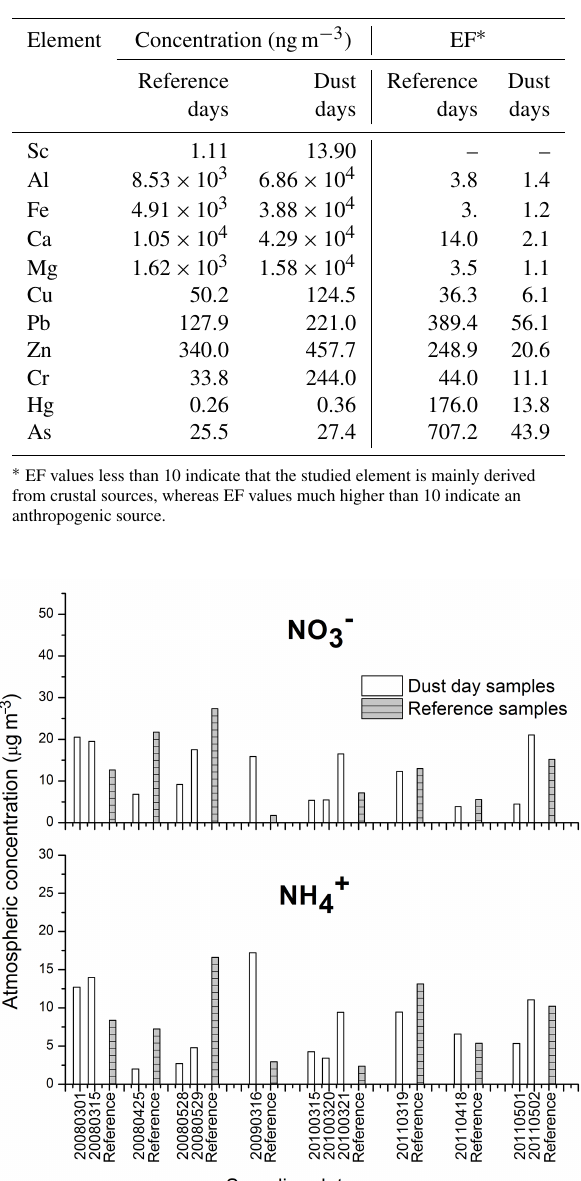
and NO − in aerosol sam- 4 3